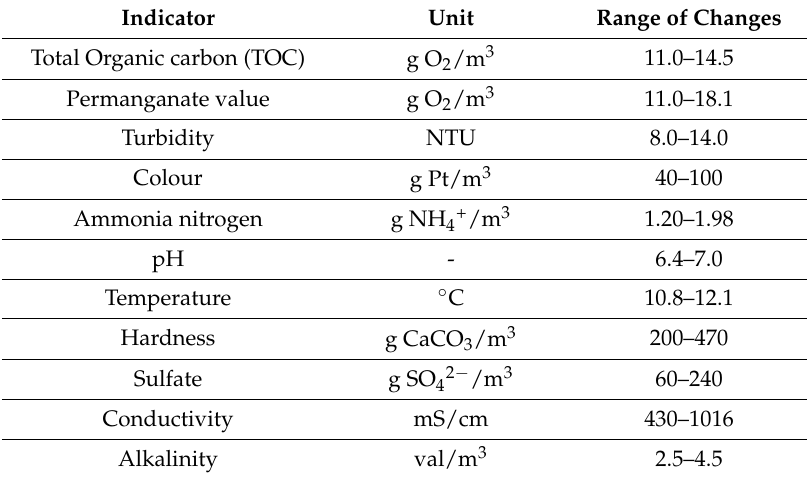
Table 1. Physicochemical quality of underground water (data from